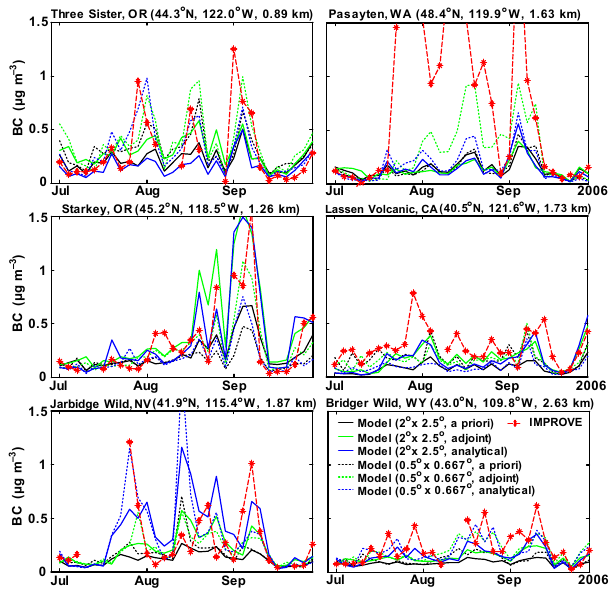
Figure 8. Observed (red line) and GEOS-Chem simulated 24h av- erage surface BC concentrations (µgm − 3 ) at six IMPROVE sites for July–September 2006. Results are for 2 ◦ × 2.5 ◦ (solid) and 0.5 ◦ × 0.667 ◦ (dotted line) with the a priori (black line) or a pos- teriori emissions from the analytical (blue line) or adjoint (green line)